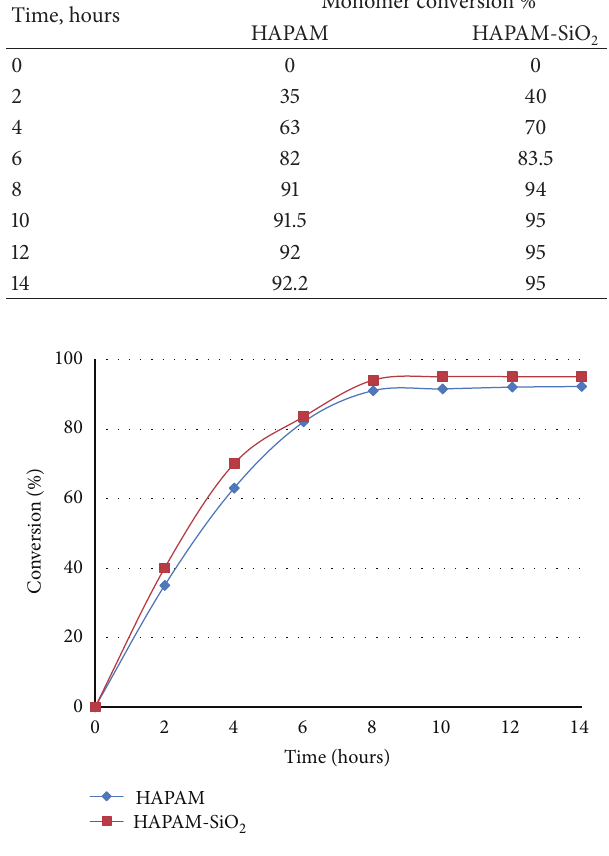
Figure 11: Monomer conversion with time. Table 10: Factors and levels.